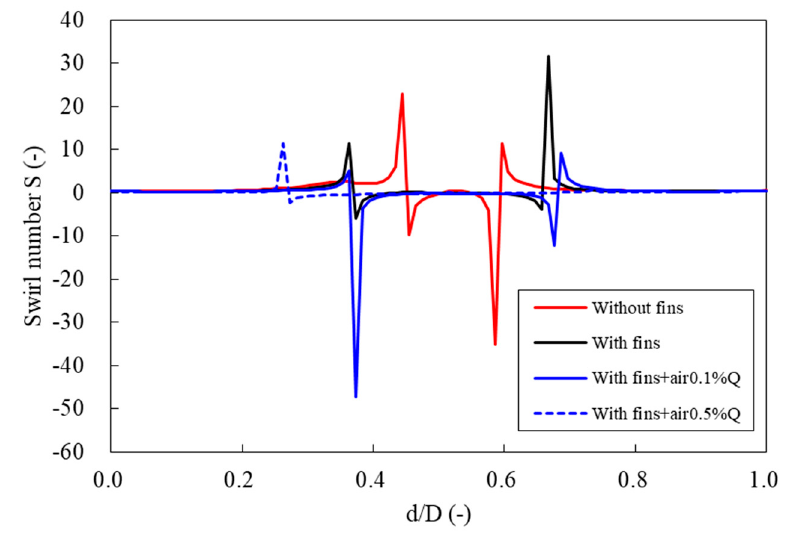
Figure 11. Swirl number distributions corresponding to the observed line in the DT.